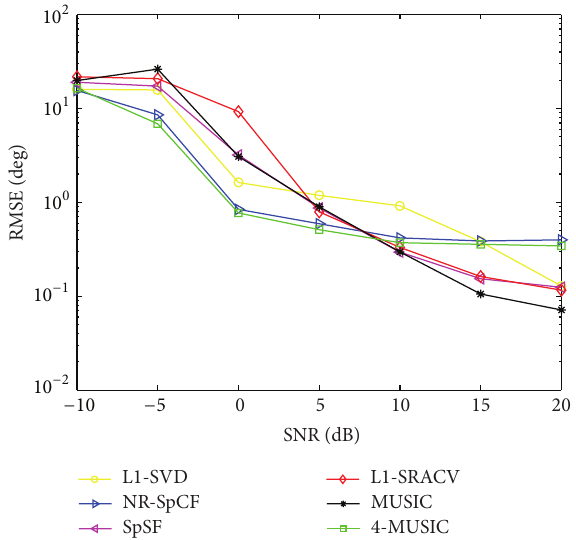
Figure 2: Spatial spectra of NR-SpCF and 4-MUSIC for underde- termined DOA estimation case, when 𝑀 = 4 , 𝑄 = 6 . The real DOAs are marked by the circles.